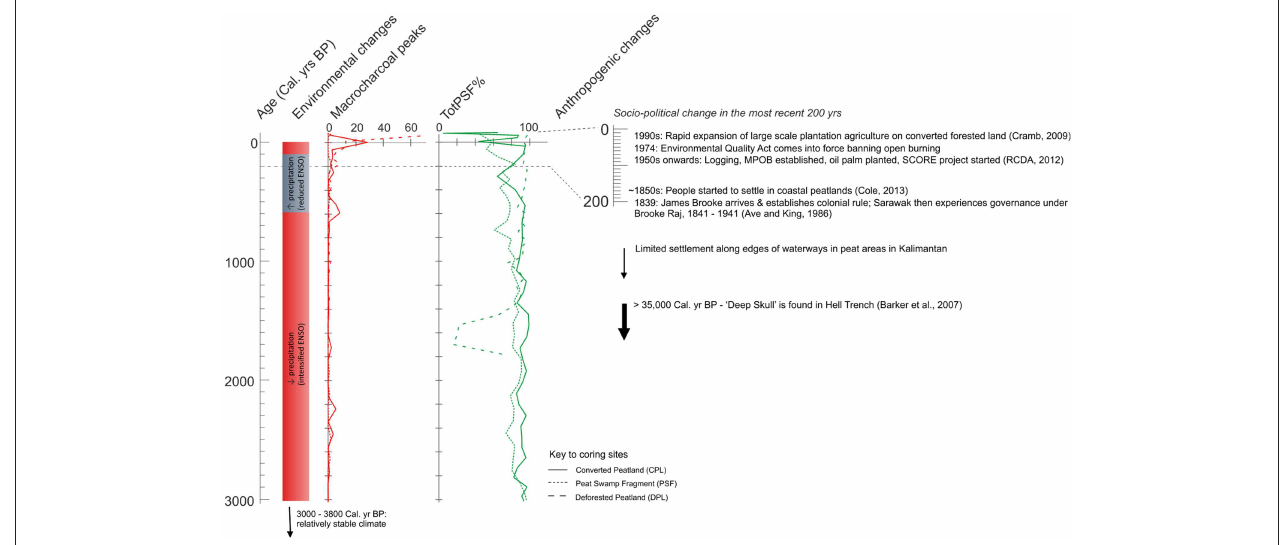
FIGURE 5 | Composite diagram illustrating the environmental, anthropogenic, and peat swamp forest ecological changes occurring within the study region over the last 3,000 years, from the first distinct phase of elevated burning across two sites (CPL and PSF, Figure 3 ). Historical and climatic drivers of past fire incidence within Sarawak’s coastal peatlands have been identified through a literature search and interviews ( Cole, 2013), with the most recent 200 years hosting a period of significant socio-political change. Variability in macrocharcoal peaks ( C peak , measured in peak component charcoal accumulation rate (cm 3 /yr), see Figure 2 , Supporting Material) and TotPSF% (percentage of pollen sum) across all cores are represented on separate axes, aligning with one chronological scale. (For more information on: ENSO variability, see Table S3 , Supporting Material; and the history of political development in Sarawak, see (Cramb et al., 2009) and references